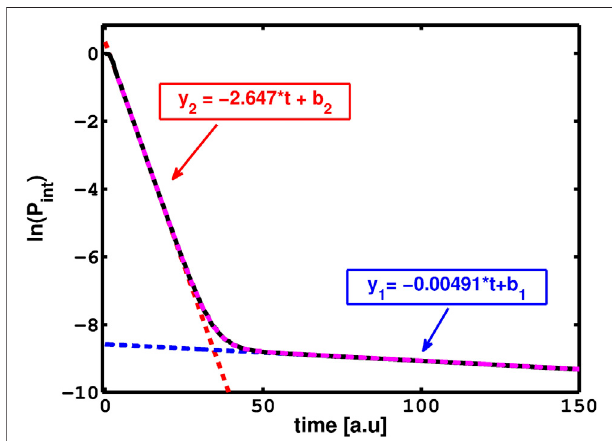
FIGURE 2 | The survival probability, P int = | 〈 Ψ (0)| Ψ ( t ) 〉 | 2 , as a function of time. The initial Gaussian mainly populates the two narrowest resonances of the model potential V ( x ) = ( x 2 /2 + 0.8)exp( − 0.2 x 2 ). The slope of each line represents the decay rate of each resonance. The larger slope (of y 2 ) is the decay rateof the shorter resonance while thesmaller slope (of y 1 ) isfor the longer (i.e. narrower) resonance. Reprinted by permission of the publisher (Taylor & Francis Ltd,